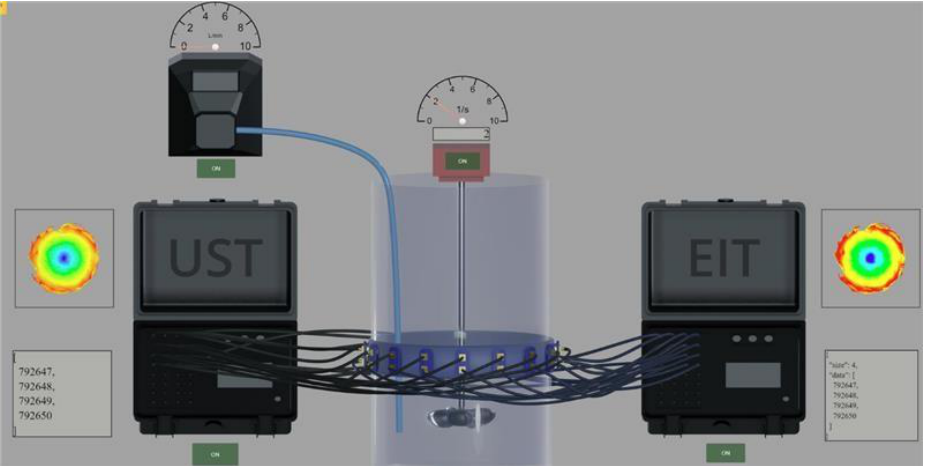
Figure 13. User control panel.